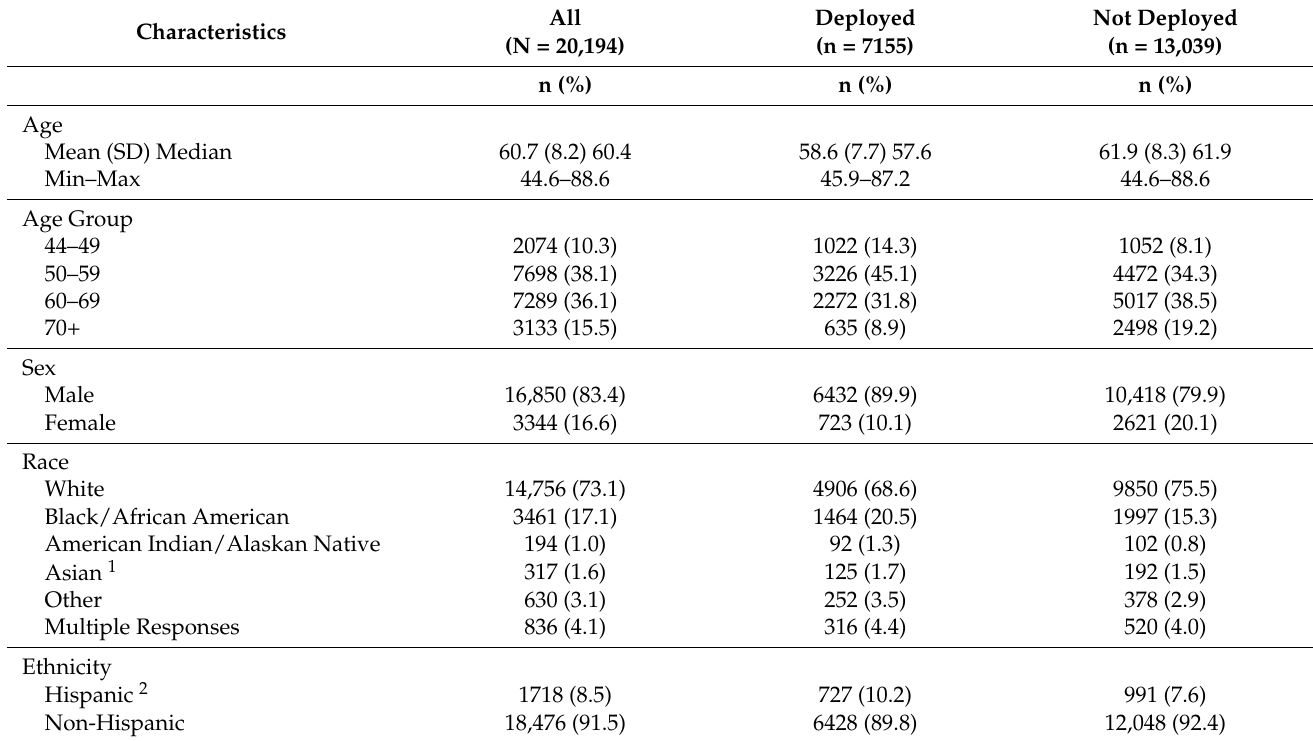
Table A5. Complete Case Analyses for Characteristics of Gulf War Era Veterans in the VA CSP 2006/MVP 029 cohort by deployed and non-deployed